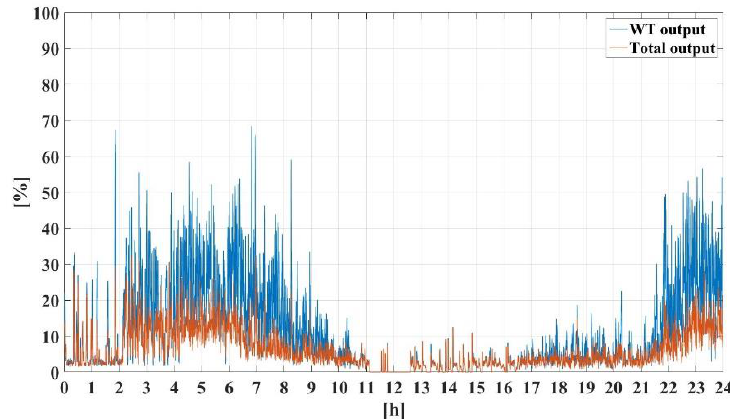
Figure 7. Field test result 1: fluctuation rate per minute.